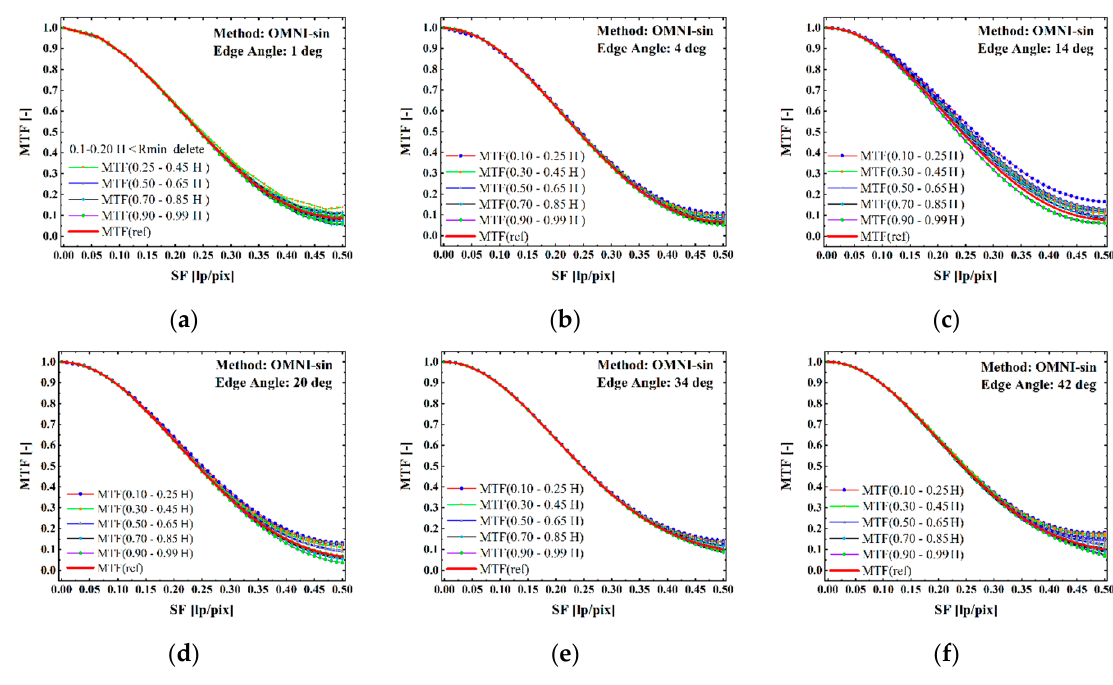
Figure 11. MTF for some tilt angle BDE images when adopt different ROI-H (0.10~0.99) using OMNI-sin edge method: ( a ) when edge angle is 1 deg, ( b ) when edge angle is 4 deg, ( c ) when edge angle is 14 deg, ( d ) when edge angle is 20 deg, ( e ) when edge angle is 34 deg, ( f ) when edge angle is 42 deg.